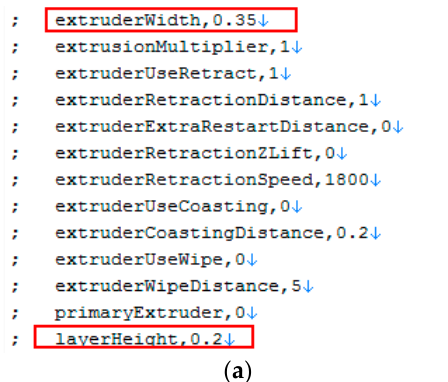
Figure 2. Printed filaments geometry: ( a ) Segment form the printed G-code; ( b ) Theoretical dimen- sions of a fiber.